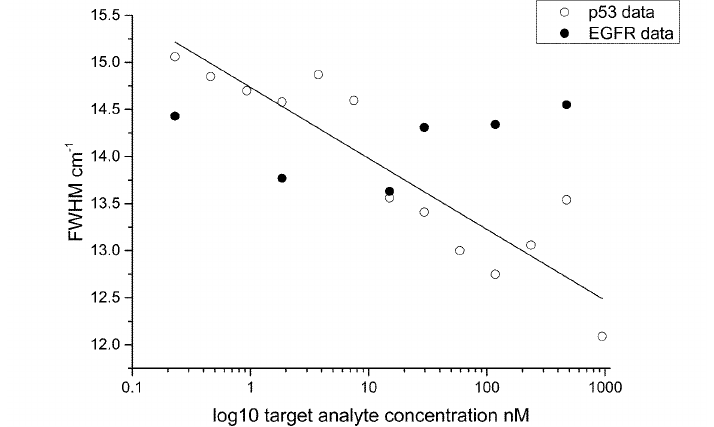
Figure 7. Semi-log plot of the FWHM data for p53/4-ATP. Overlaid on this plot is data for the EGFR-ATP